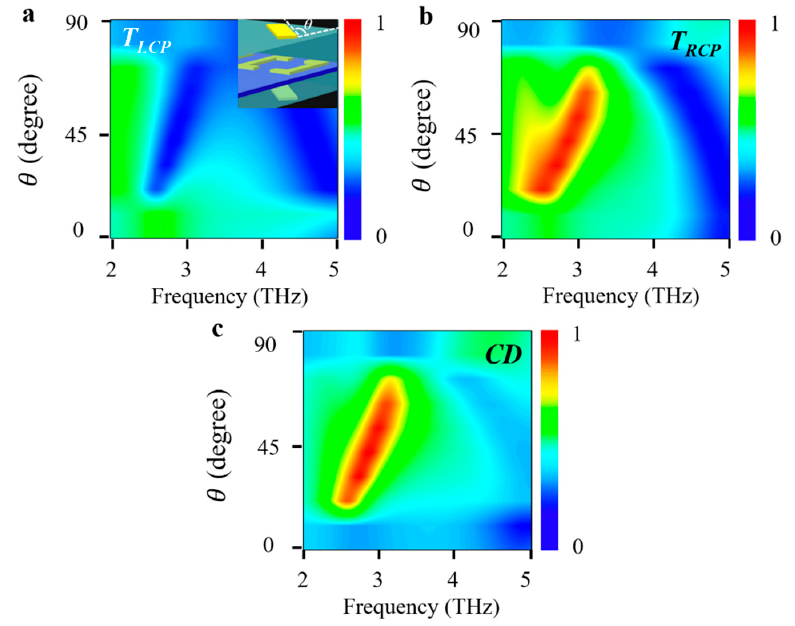
Figure 4. The transmission spectra versus different rotation angles θ for the illumination of ( a ) RCP light and ( b ) LCP light. ( c ) The corresponding CD response spectra versus different rotation angles θ . The inset in ( a ) depicts the related geometric parameter and VO 2 is in the isolating state.